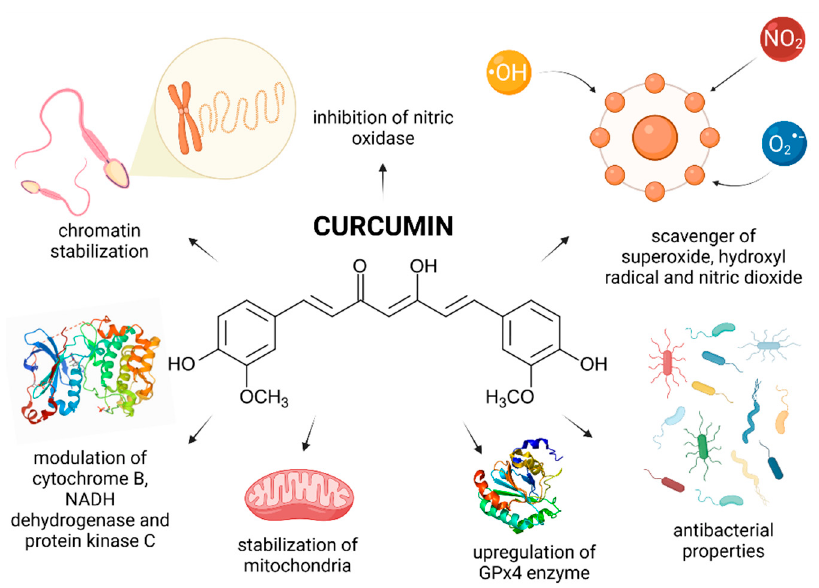
Figure 5. Most frequently reported beneficial effects of curcumin on spermatogenesis, sperm struc- tural integrity and functional activity.